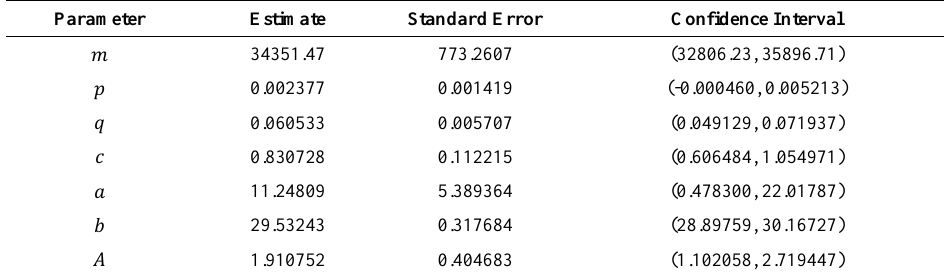
Table A15. Piedmont. Estimates, asymptotic standard errors and 95% mCIs for the parameters of the BeGBM 𝑹𝑬𝑪𝑻 (7)+(5).